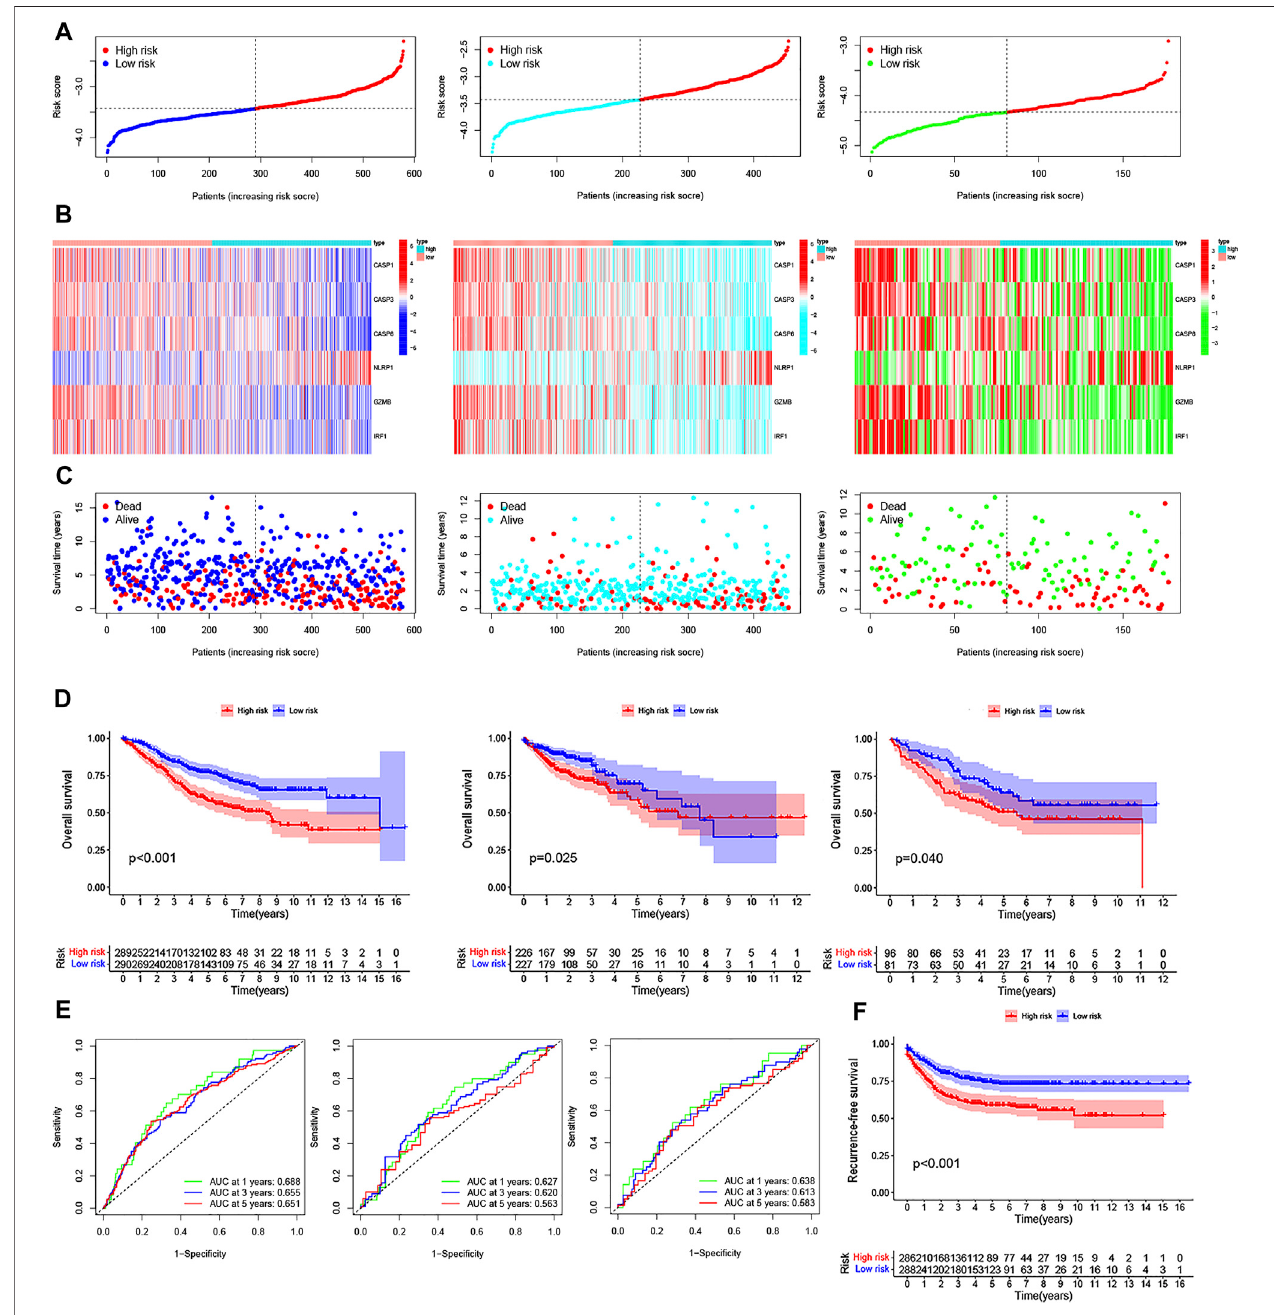
FIGURE 5 | Construction of the PRG signature to predict patient survival. (A – C) Distribution of the risk score, survival time and survival status, and the heatmap of the six PRGs signatures in GSE39582, TCGA, and GSE17536 cohorts between the high- and low-risk groups, respectively. (D) Kaplan – Meier survival curves of the OS for patients in GSE39582, TCGA, and GSE17536 cohorts between the high- and low-risk groups, respectively. (E) 1-, 3-, and 5-year ROC curves of the PRG signature for the OS prediction in GSE39582, TCGA, and GSE17536 cohorts, respectively. (F) Kaplan – Meier survival curves of the relative RFS between the high- and low- risk groups in the GSE39582